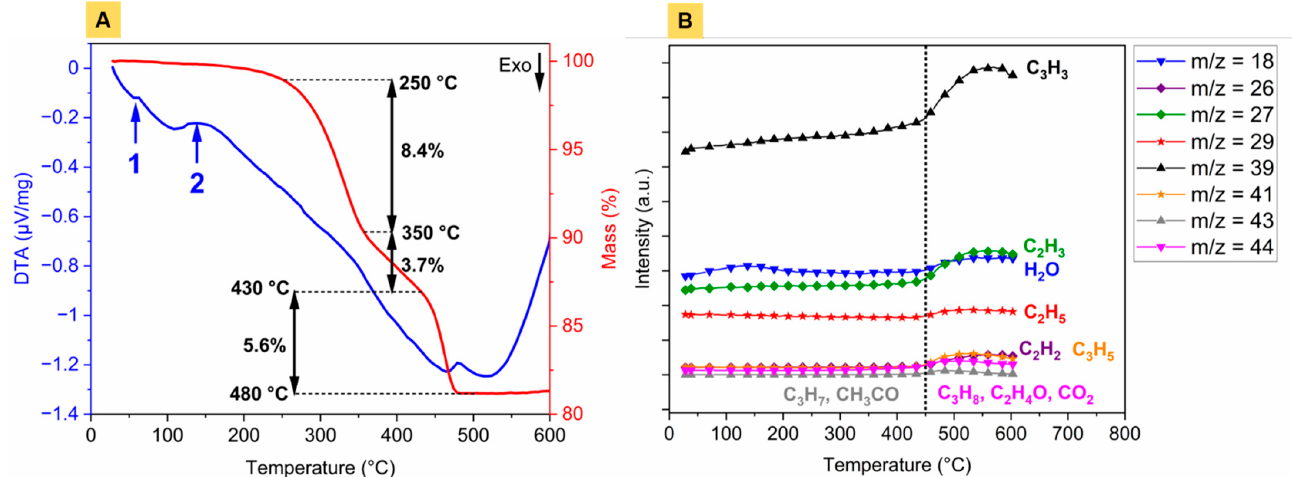
Figure 2. Binder burnout, analysed by ( A ) DTA/TG coupled to ( B ) mass spectrometry with corresponding QMID ion current curves. Number 1 on the DTA curve ( A ) corresponds to the melting point of paraffin wax (65 °C) and stearic acid (67 °C); number 2 represents water evaporation. Mass to charge ratio is given by m/z on ( B ).